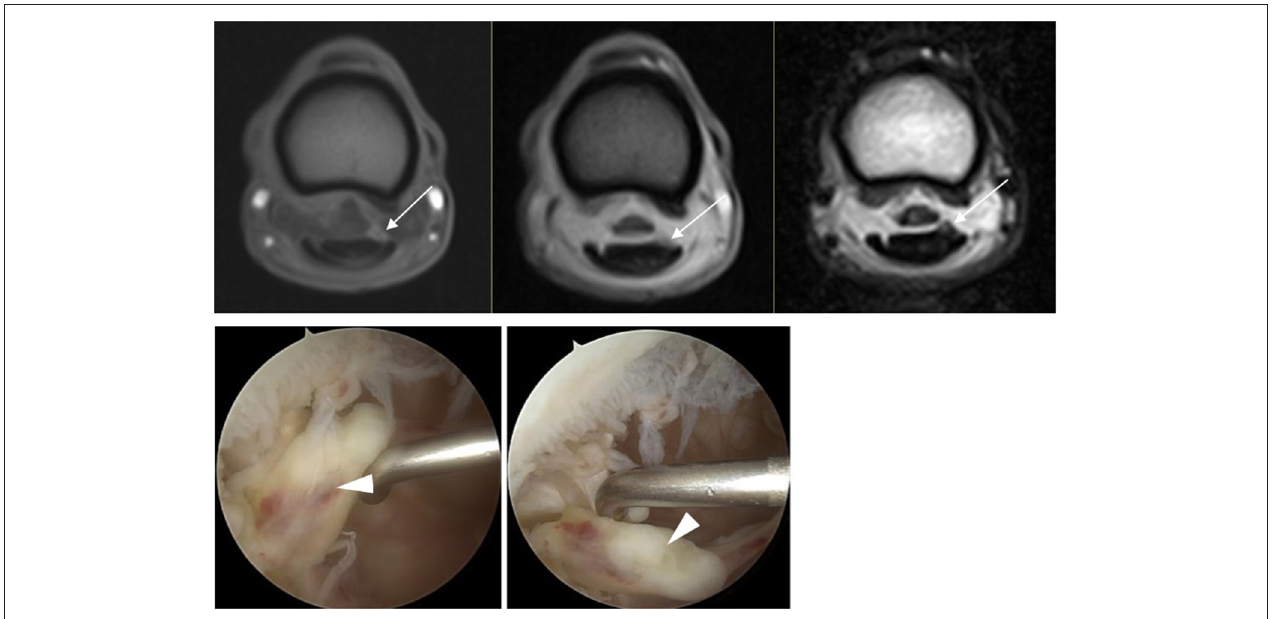
FIGURE 2 | In the top row, from left to right T1W GRE, T2*W GRE, and T2W FSE(c) images of a dorsolateral DDFT injury at the level of the proximal phalanx where the DDFT goes from ovoid to bilobed in a LF limb (lateral to the right of the image). The injury is evident on all sequences (white arrow) and has high SI on T1W GRE and intermediate SI on T2*W GRE and T2W FSE images. The appearance during tenoscopic examination is shown in the bottom row images (white arrowhead) (tenoscopic images courtesy of Dierenkliniek Emmeloord).